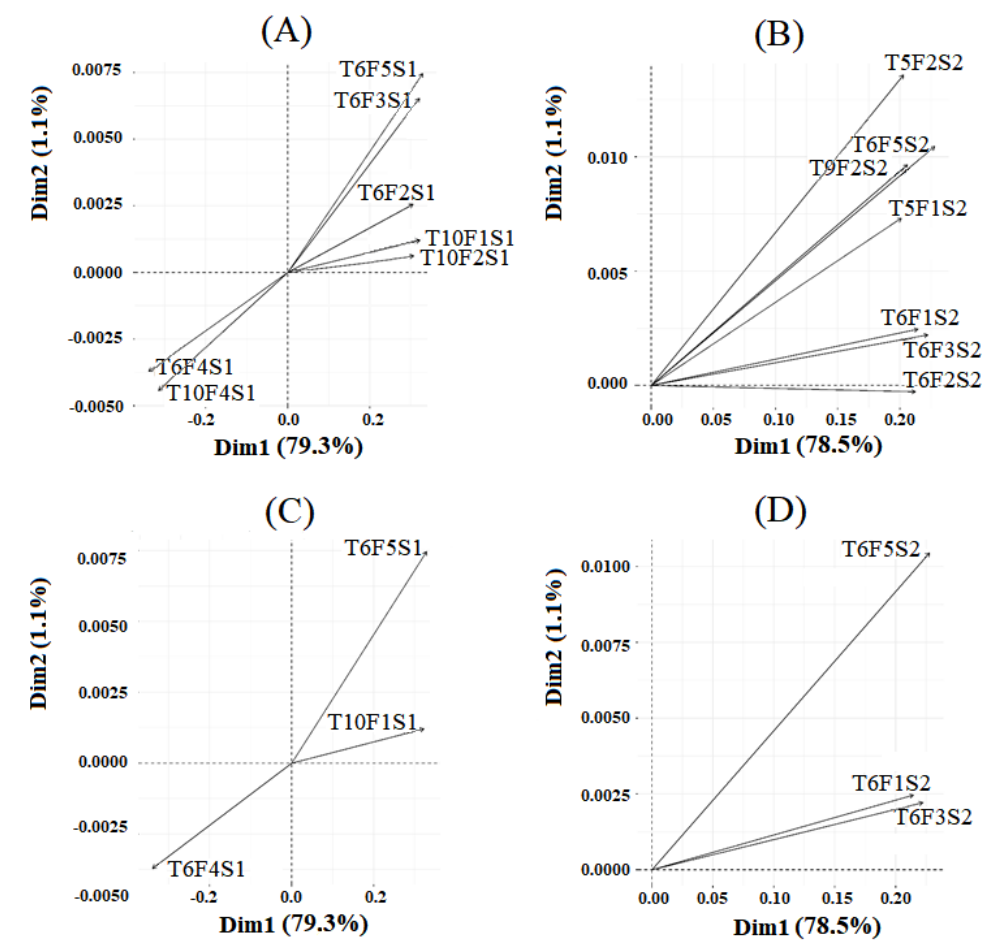
Figure 9. Scree plot for the radial-ulnar — y-axis (S1) and proximal-distal z-axis (S2).